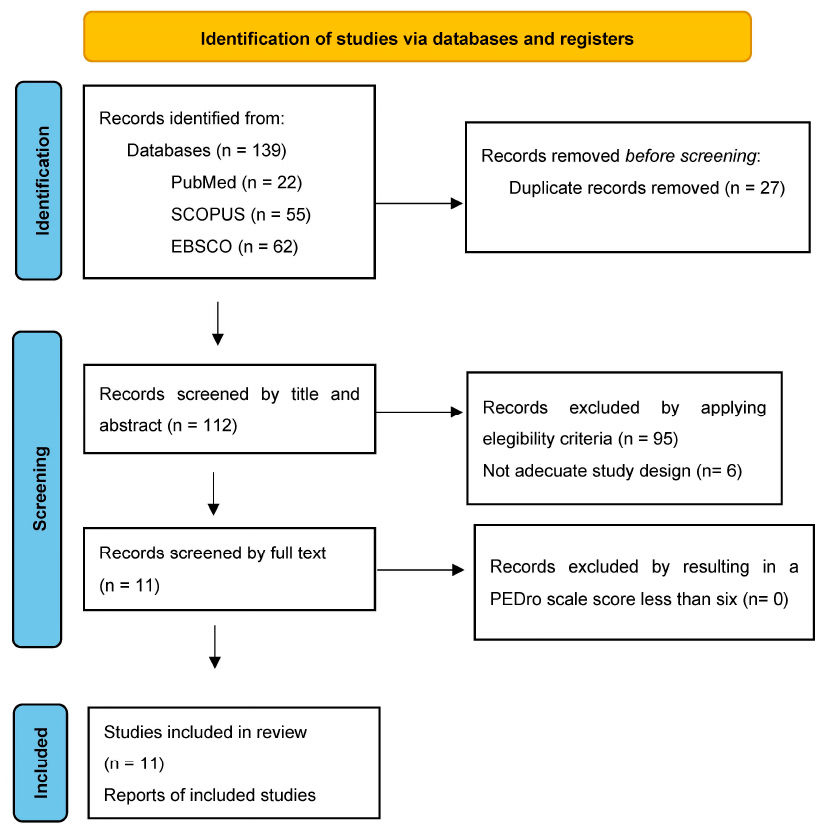
Figure 1. PRISMA 2020 flow diagram for new systematic reviews.